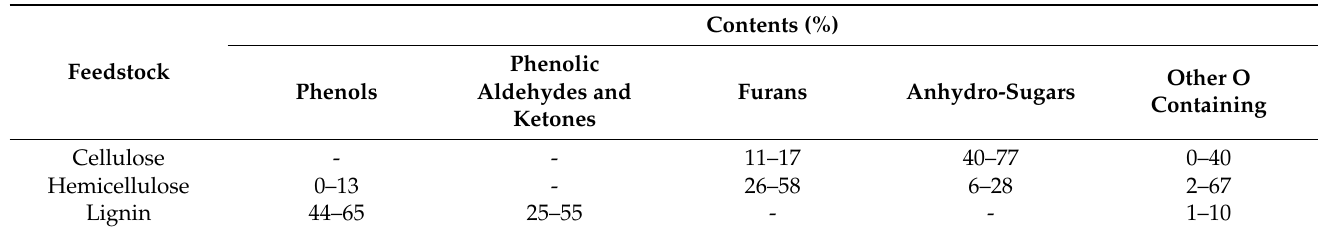
Table 3. Summary of fast pyrolysis products of cellulose, hemicellulose, and lignin. Adapted from [50].